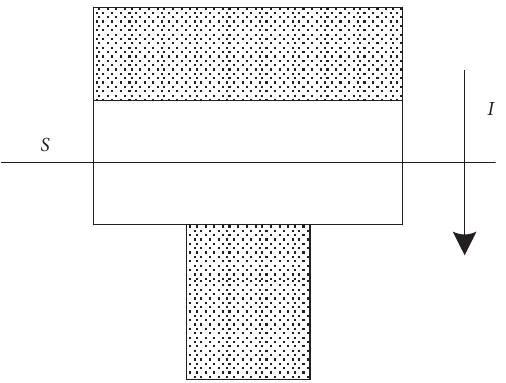
Figure 5: Schematic diagram of calculating the total resistance of the resistance change unit. Table 2: Pulse parameters.